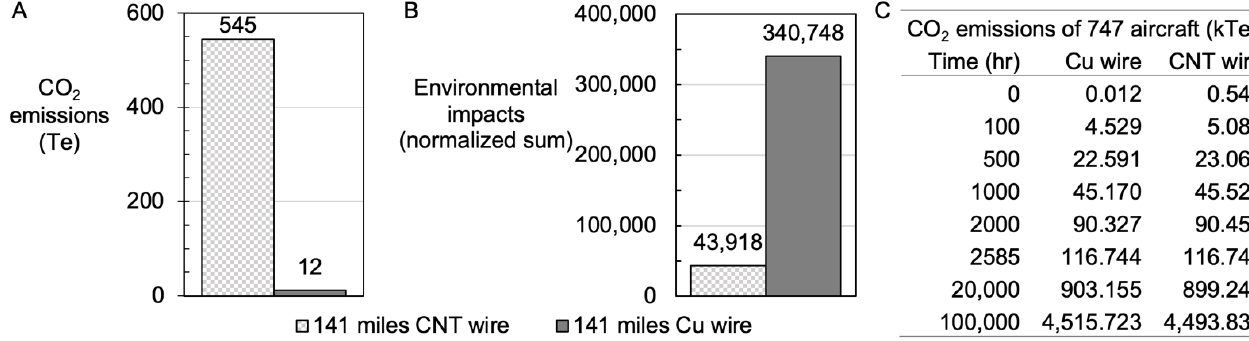
Figure 7. Life cycle analysis comparing ( A ) CO 2 emissions and ( B ) normalized sum of all environ- mental impacts between the production of 141 miles of CNTs wires versus Cu wire. Comparative table ( C ) showing the CO 2 emission (kTe) per copper versus CNT wires.